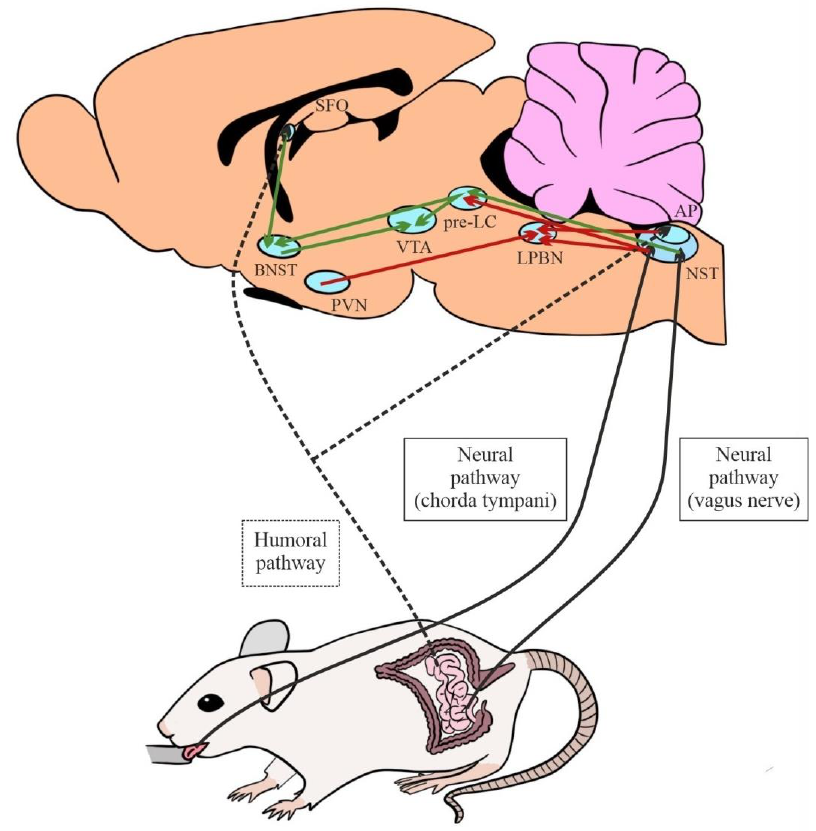
Figure 4. Afferent neural and humoral pathways involved in salt intake and main central excitatory (green) and inhibitory (red) circuits (AP: area postrema; BNST: bed nucleus of the stria terminalis; LPBN: lateral parabrachial nucleus; NST: nucleus of the solitary tract; pre-LC: pre-locus coeruleus; PVN: paraventricular nucleus; SFO: subfornical organ; VTA: ventral tegmental area).